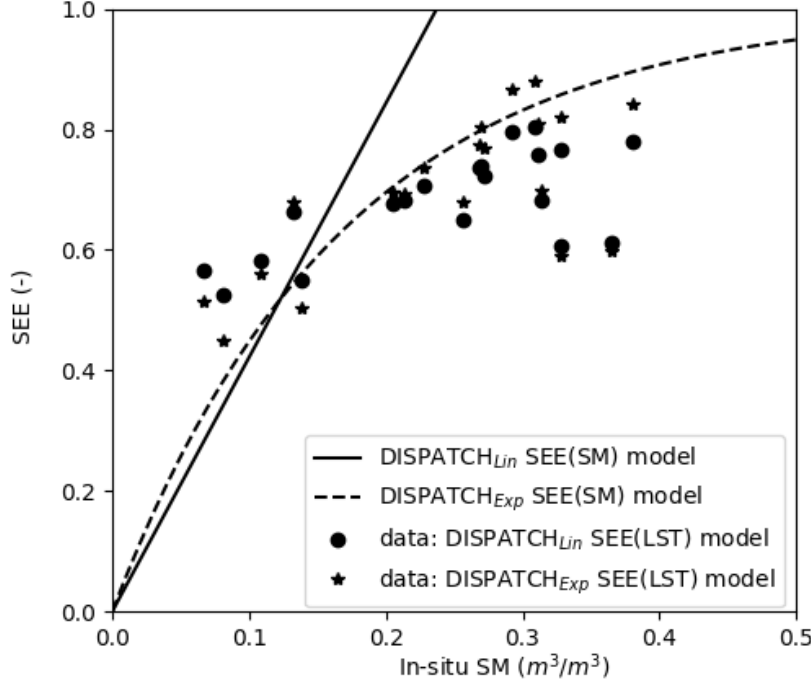
Figure 5. Landsat-derived SEE as a function of in situ SM superimposed with the SEE(SM) model for both DISPATCH Lin and DISPATCH Exp algorithms, for data on DOY